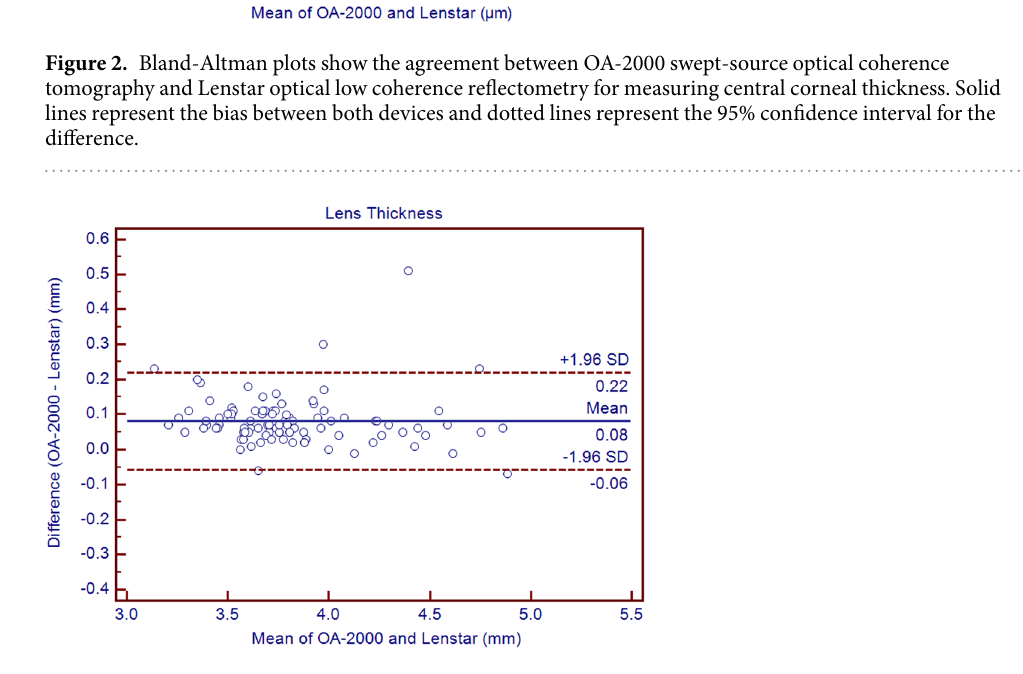
Figure 3. Bland-Altman plots show the agreement between OA-2000 swept-source optical coherence tomography and Lenstar optical low coherence reflectometry for measuring lens thickness. Solid lines represent the bias between both devices and dotted lines represent the 95% confidence interval for the